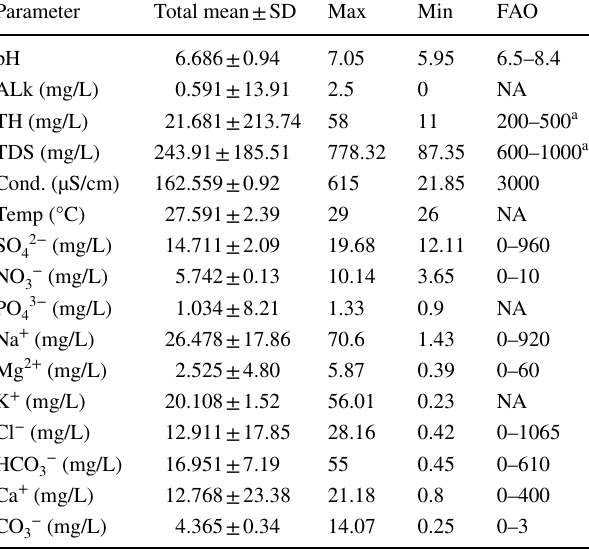
Table 3 Total mean concentration of physicochemical parameters and FAO standard for irrigation water